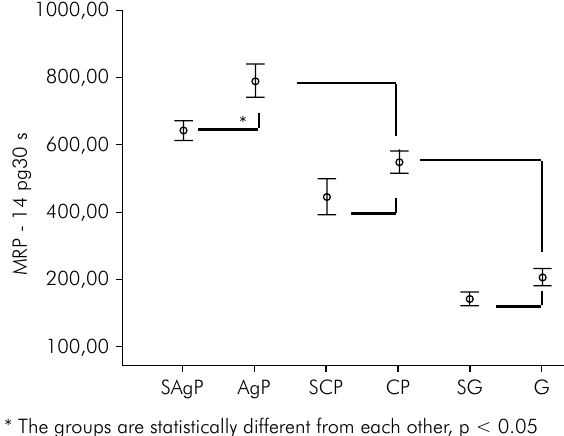
Figure 2. The comparison of the myeloid-related protein-14 (MRP- 14) total levels of patients diagnosed with generalized aggressive periodontitis (SAgP) with smoking, chronic periodontitis (SCP) with smoking, gingivitis (SG) with smoking, generalized aggressive periodontitis (AgP) without smoking, chronic periodontitis (CP) without smoking, and gingivitis (G) without smoking.